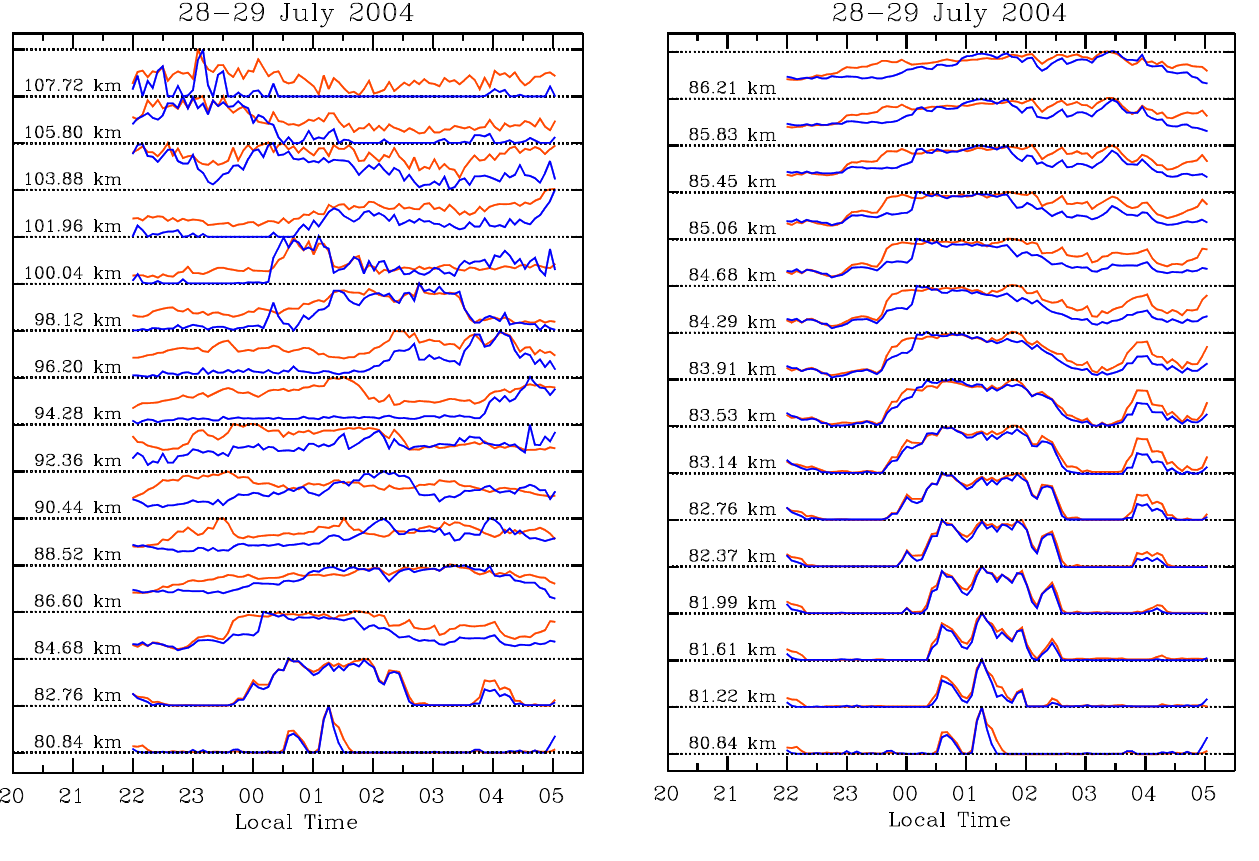
Fig. 5. Time variations of the relative densities for Na (orange line) and Fe (blue line) observed at altitudes between 80.84 and 107.72km (plotted in every 20 altitude bins) during the night of 28–29 July 2004. Note that the temporal variations of the Na and Fe relative densities show an excellent similarity on the bottommost layer underside between 80.84 and 82.76km, particularly on small time scale.